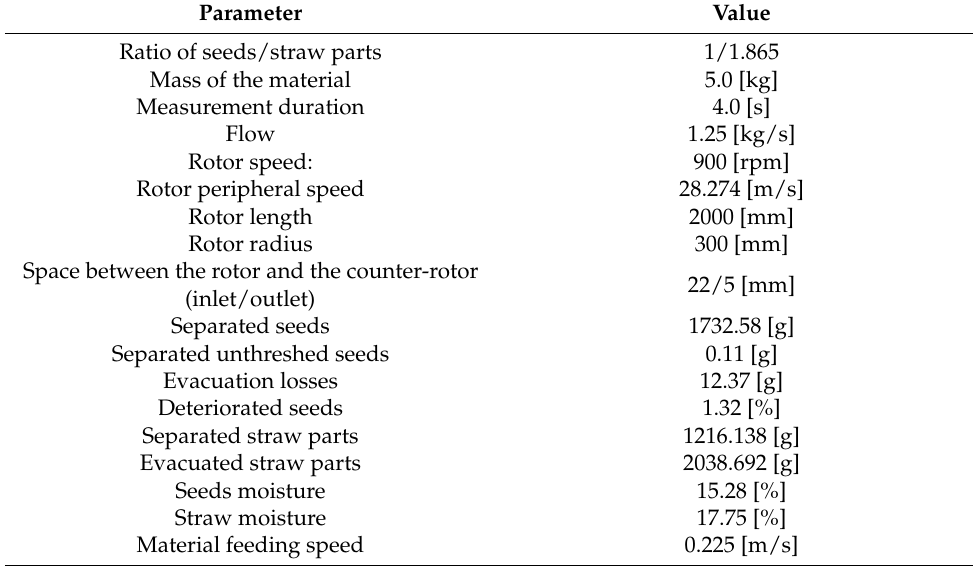
Table 1. The main parameters of the experiences achieved on the Fundulea 4 wheat variety. Parameter Value Ratio of seeds/straw parts 1/1.865 Mass of the material 5.0 [kg] Measurement duration 4.0 [s] Flow 1.25 [kg/s] Rotor speed: 900 [rpm] Rotor peripheral speed 28.274 [m/s] Rotor length 2000 [mm] Rotor radius 300 [mm] Space between the rotor and the counter-rotor 22/5 [mm] (inlet/outlet) Separated seeds 1732.58 [g] Separated unthreshed seeds 0.11 [g] Evacuation losses 12.37 [g] Deteriorated seeds 1.32 [%] Separated straw parts 1216.138 [g] Evacuated straw parts 2038.692 [g] Seeds moisture 15.28 [%] Straw moisture 17.75 [%] Material feeding speed 0.225